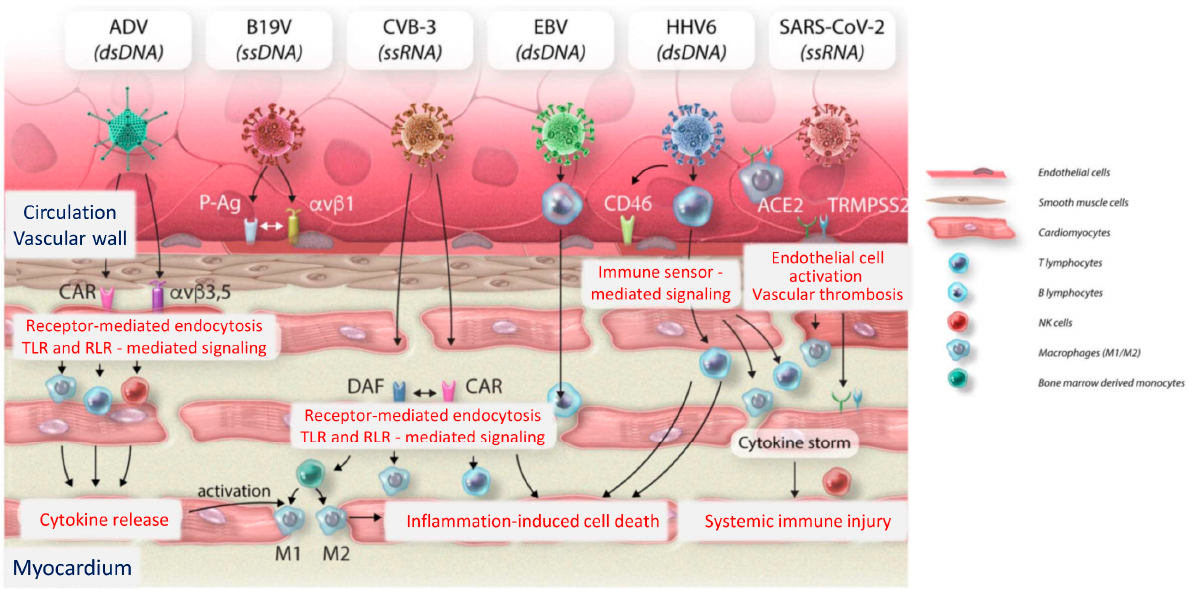
Figure 6. Cellular receptor-mediated entry and innate immune activation mechanisms of human- pathogenic viruses (modified from Cardiovasc. Res. 2022 [ 163 ] by permission). Depicted are the most abundant cardiotropic viruses, as well as SARS-CoV-2, and their molecular entry mechanism into cardiovascular cells in the heart. CVB-3 and ADV enter cardiomyocytes via binding the transmembrane CAR. In addition, decay-accelerating factor serves as CVB-3 receptor. Integrins ( α v β 3 and α v β 5) promote ADV internalization. B19V targets endothelial cells by binding to erythrocyte P antigen and integrin α v β 1 as co-receptor. EBV efficiently infects resting human B lymphocytes, whereas HHV6 primarily targets CD4+ T lymphocytes. Using CD46 as cellular receptor, HHV6 can directly infect endothelial cells and subsequently enter adjacent tissues. SARS-CoV-2 cellular entry involves specific binding to the ACE2 receptor, as well as proteolytic cleavage by the host cell sur- face serine protease TMPRSS2. For SARS-CoV-2, several cardiac targets including vascular endo- thelial cells and cardiomyocytes are proposed. Moreover, pulmonary-derived macrophages are sug- gested, carrying the virus into the myocardium. As a consequence of receptor-dependent cellular entry through the endo-lysosomal pathway, a TLR innate immune signaling cascade is initiated, followed by infiltration by inflammatory cells (T and B lymphocytes, natural killer cells, bone-mar- row derived monocytes) which differentiate into M1 and M2 macrophages. ds, double stranded; ss, single-stranded. (Modified from ref. 163 by permission of Cardiovasc. Res.).